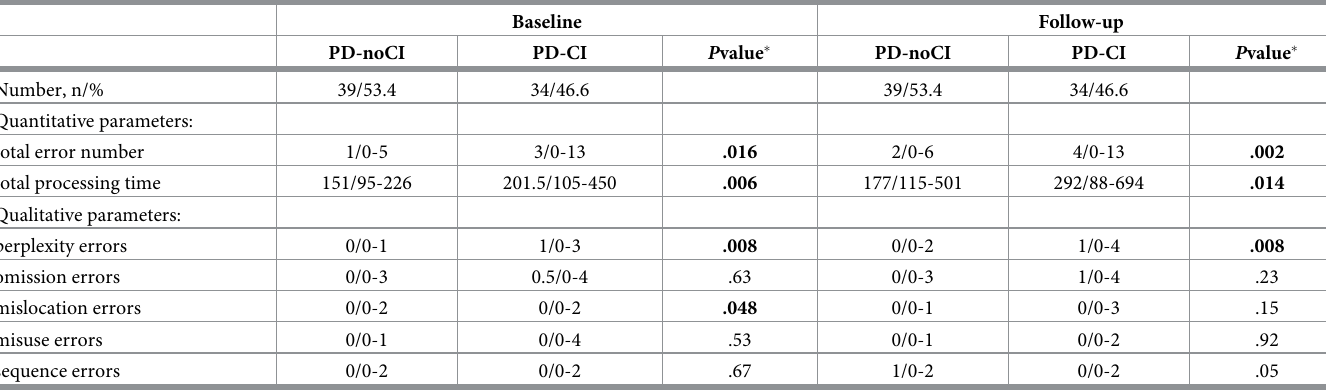
Table 4. Comparison of MOT parameters of PD patients with (PD-CI) and without (PD-noCI) cognitive impairment at baseline and follow-up visit.